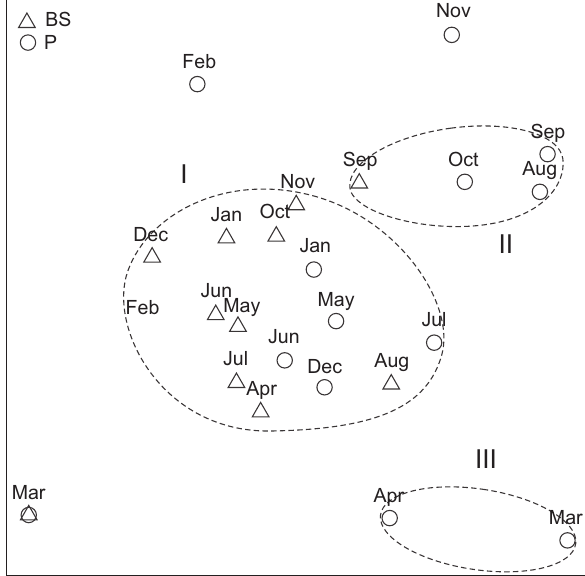
Figure 4. nMDS applied to fish abundance data (transformed by the fourth root) from accompanying fauna from seabob shrimp bycatch collected monthly in Balneário Barra do Sul (BS) and Penha (P) (Stress = 0.17). Dotted ellipsis represents the clusters at 60% of